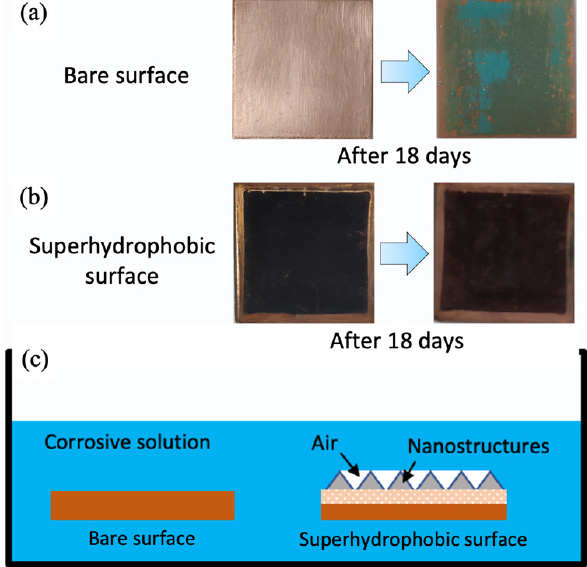
Figure 13. The optical images of the bare copper surface and superhydrophobic surface ( a ) before and ( b ) after immersion into a 5 wt% NaCl solution; and ( c ) anti-corrosion mechanism of the superhydrophobic